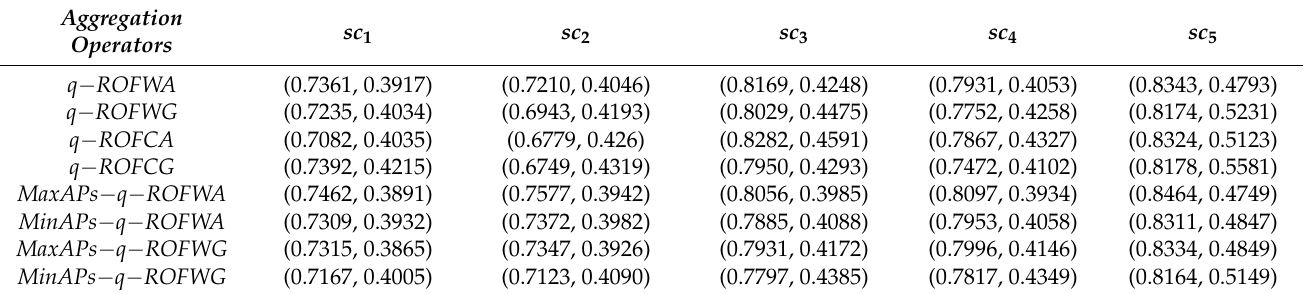
Table 8. The evaluations of SRIs by the q-ROF operators based on q-ROFNs matrix (Table 6).